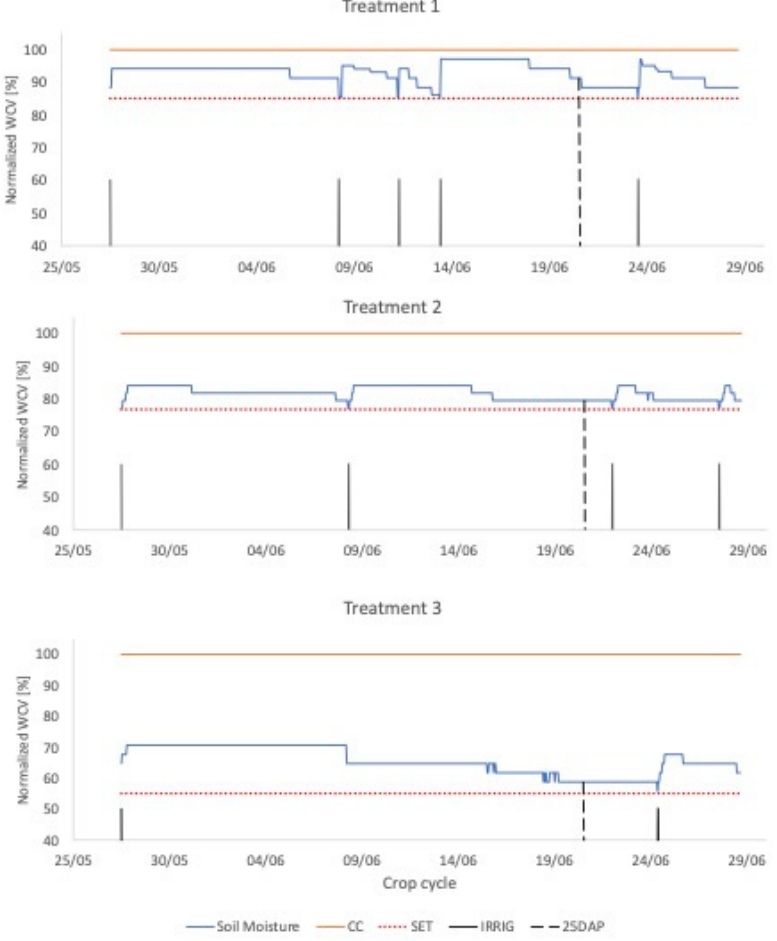
Figure 9. Moisture monitoring for each treatment throughout the crop cycle, where the VCW (Volumetric Water Content) values were normalized. Treatment 1 (T 1 = 85% FC (Field Capacity)); Treatment 2 (T 2 = 75% FC); Treatment 3 (T 3 = 55% FC).